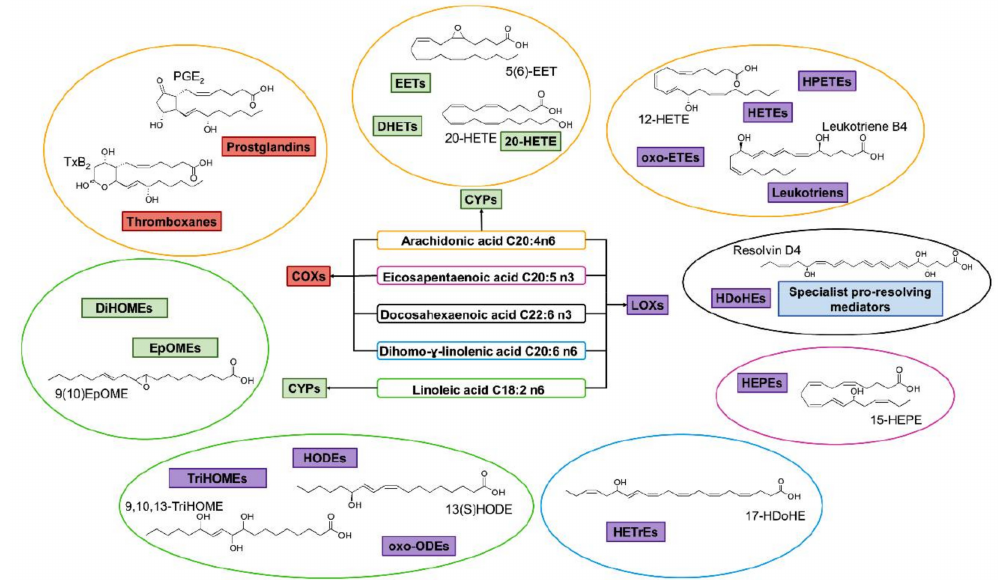
Figure 51. Oxylipin network and their fatty-acid precursors. Reprinted with permission from [179]. Copyright 2019, American Chemical